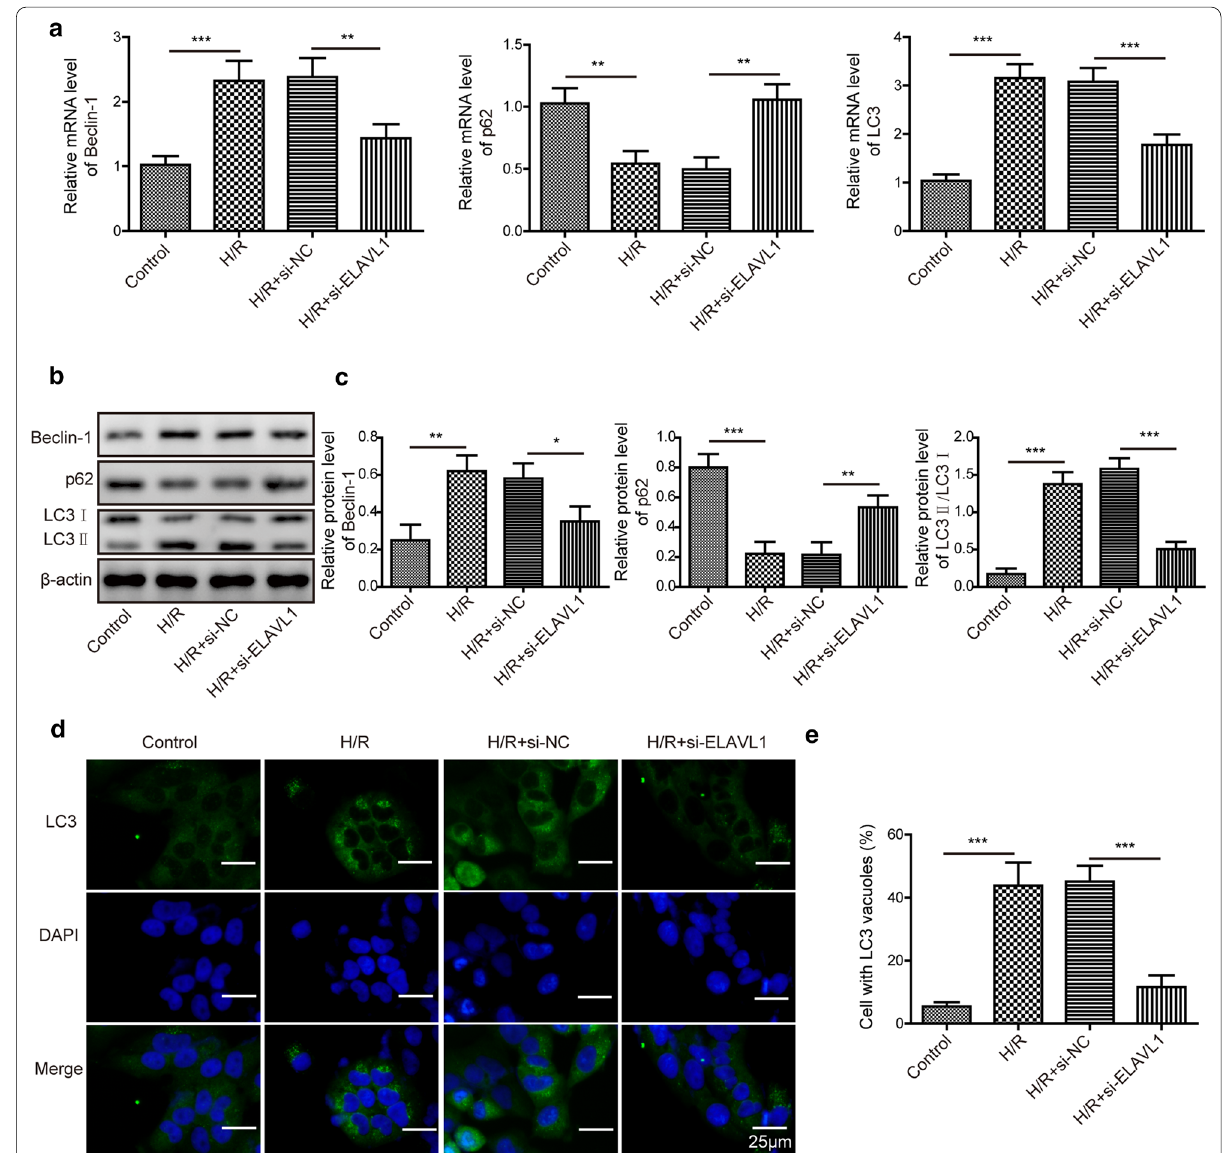
Fig. 3 ELAVL1 regulates H/R induced autophagy. Myocardial cells were transfected with si‑ELAVL1 or si‑NC and then subjected to H/R. a Relative mRNA levels of Beclin‑1, p62 and LC3 were detected by qRT‑PCR. b , c Western blotting was allowed to assess relative protein levels of Beclin‑1, p62 and LC3 in transfected cells following H/R. d , e Immunostaining analysis of cellular LC3 levels in transfected cells following H/R. The results were presented as the mean SD. n 3; * P < 0.05, ** P < 0.01, *** P < ± =